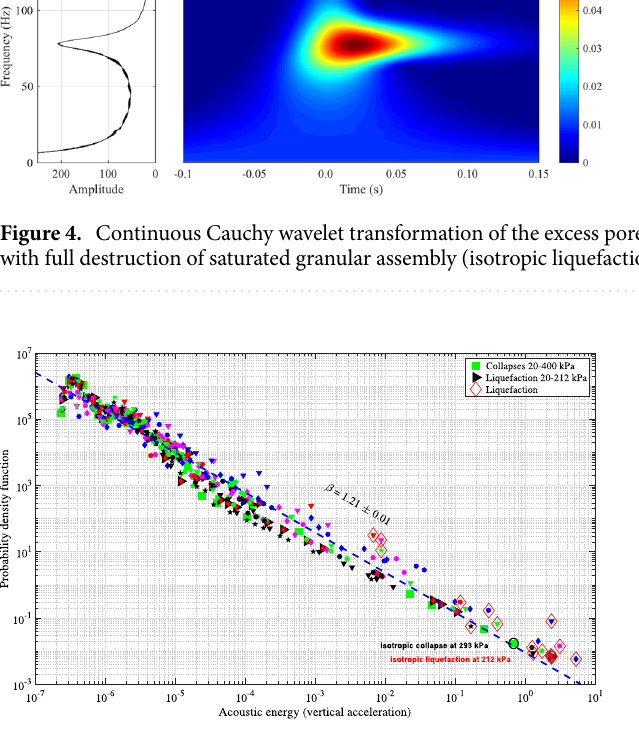
Figure 5. Probability density distribution of acoustic energy E a of the vertical top cap acceleration for isotropic collapses (solid symbols) and liquefactions (large hollow red diamonds) events. The blue dashed line represents − β 2 = 0.967. The symbol ± stands for 95% confidence the power-law behaviour, P ( E a ) ∼ E a , β = 1.21 ± 0.01, R